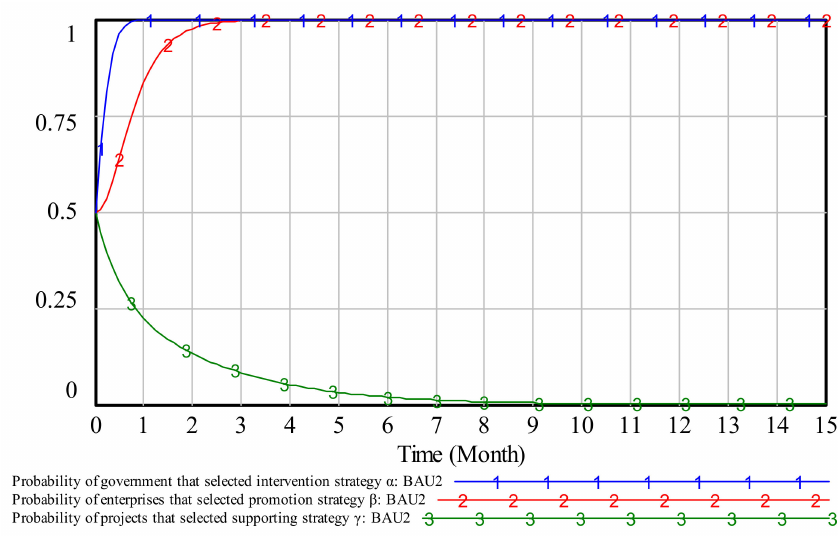
Figure 4. Stability test of the equilibrium point